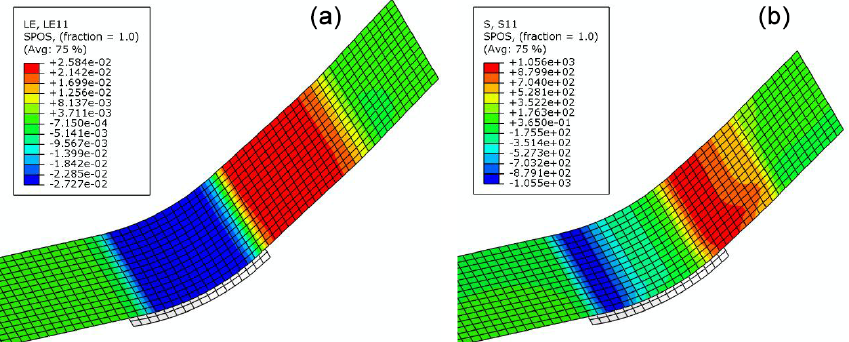
Figure 14. First principal strain (a) and stress (b) during the first segment of deformation.